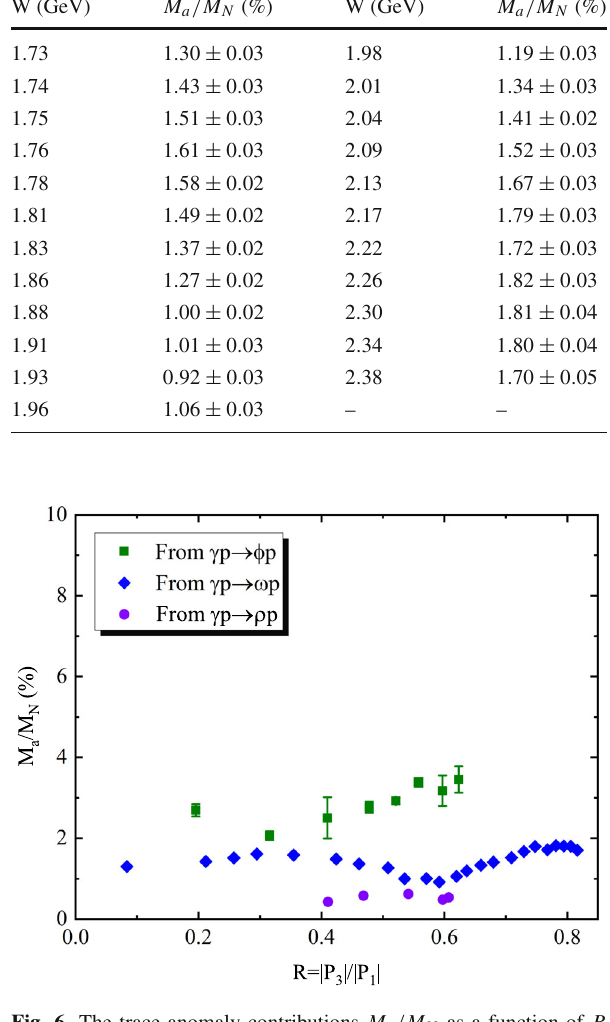
Fig. 6 The trace anomaly contributions M a / M N as a function of R extracted from the d σ/ dt | t = t of three light vector mesons photo- thr production [22,23,25–27]. The olive green square is the result from γ p → φ p from the CLAS [23] and LEPS data [22]. The blue diamond is extracted from the data of ω derived by SAPHIR Collaboration [25]. The purple circle represents the M a / M N extracted from the ρ experi- mental data developed by SAPHIR Collaboration [26,27]